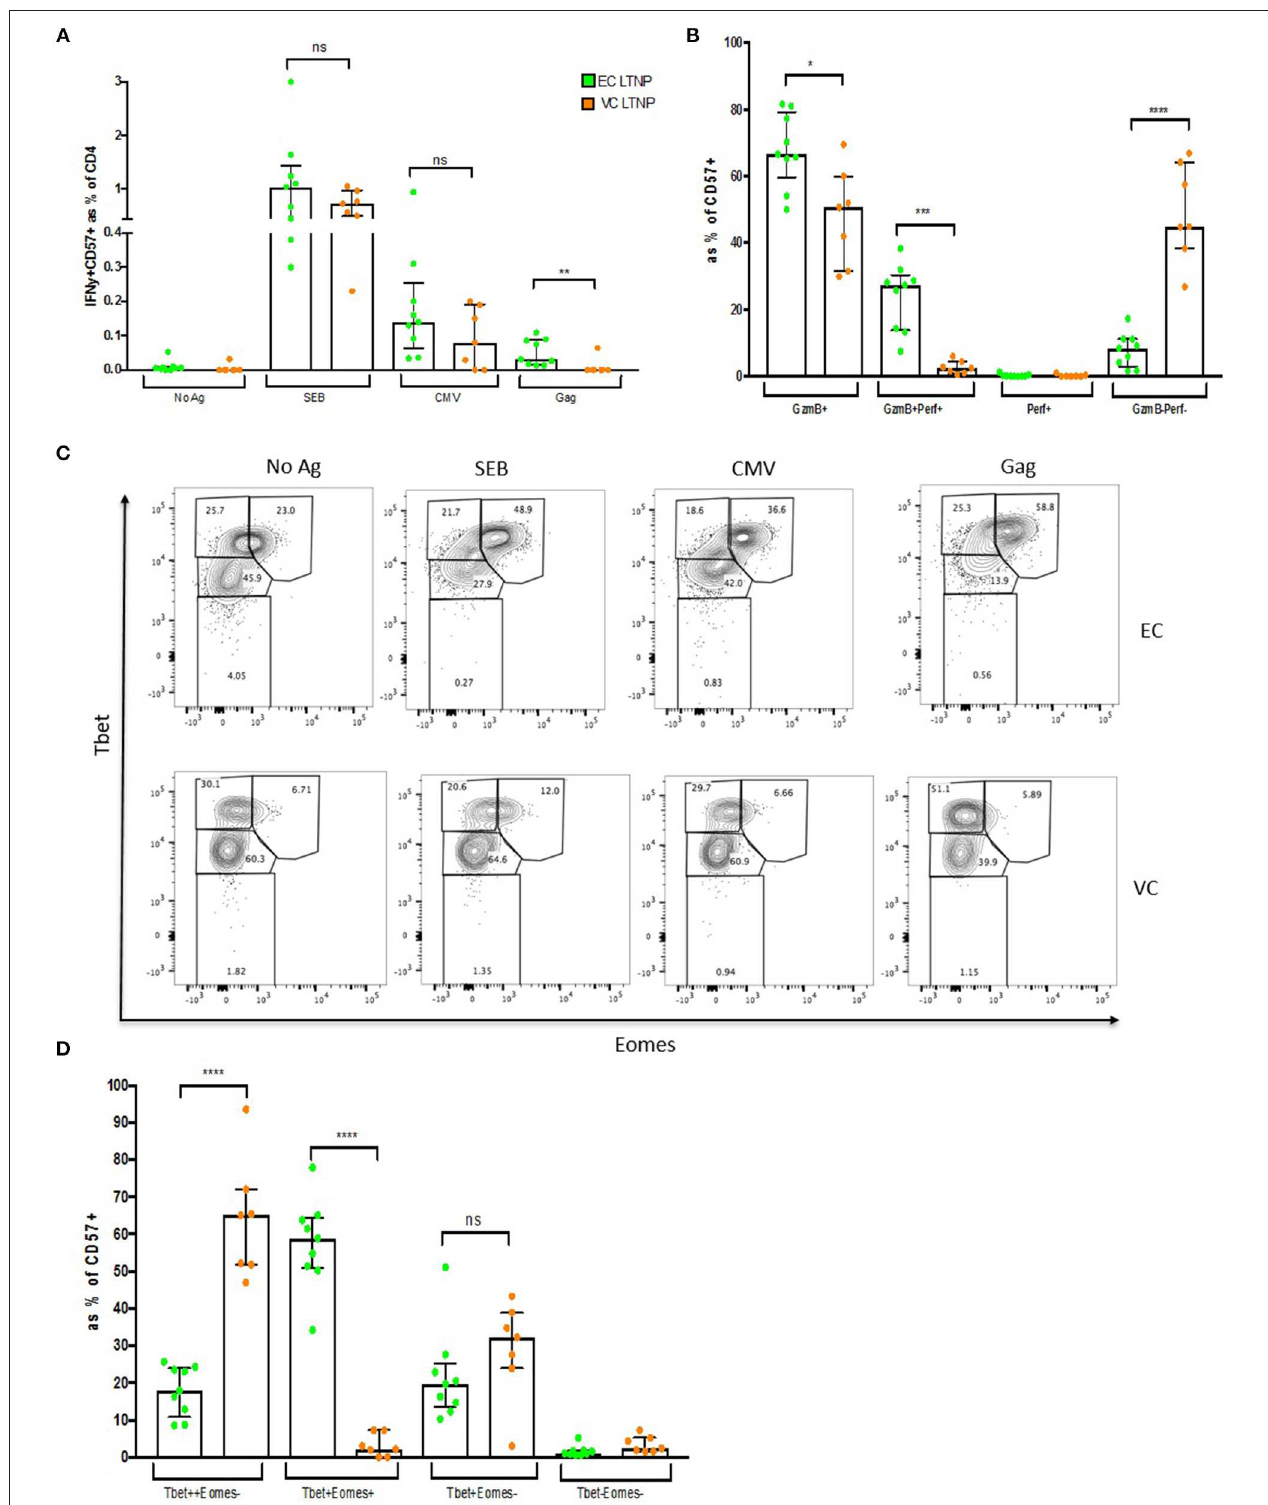
FIGURE 8 | Maintenance of HIV-specific CD57 + CD4 CTLs in EC. (A) Higher IFN γ expression within CD57 + cells in ECs compared to VCs. (B) High Gzmb + and GzmB + Perf + levels in ECs. (C) Representative dot plot showing Tbet and Eomes expression between ECs and VCs. (D) Maintenance of Tbet high Eomes + in ECs. * p < 0.05, ** p < 0.01, *** p < 0.001, **** p < 0.0001.